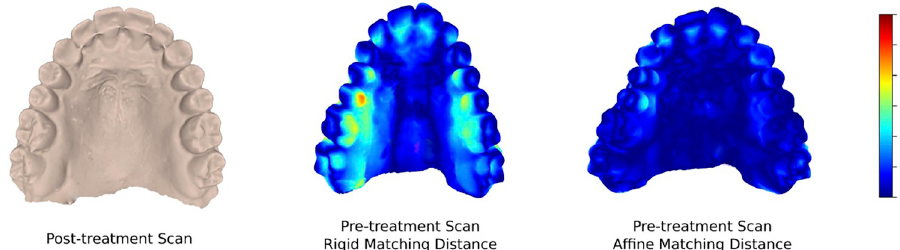
Fig 1. Comparison of affine (c) and rigid (b) registration errors (increasing scale towards red) when superimposed to the post-treatment model (a). Affine registration accurately models the palatal deformation producing a noticeably lower alignment error of the scans pre and post-treatment (showing uniform blue coloration). Pre-treatment rigid shows how the rigid alignment show allows to calculate the distance on the palatal side of the premolars, where the distance is higher but fails to measure any difference in the vestibular side, instead, affine alignment correctly stretches the two inputs resulting in a correct overlay.